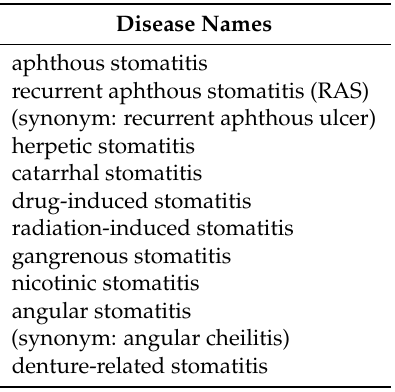
Table 1. Stomatitis-related